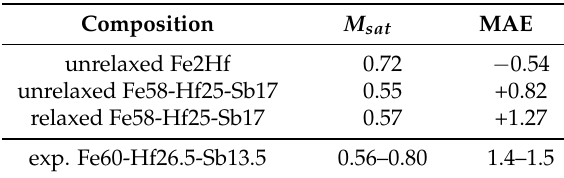
Table 2. Magnetic moment ( M sat , MA/m), and the uniaxial magnetocrystalline anisotropy (MAE ( K 1 ) , MJ/m 3 ). Composition M sat MAE unrelaxed Fe2Hf 0.72 − 0.54 unrelaxed Fe58-Hf25-Sb17 0.55 +0.82 relaxed Fe58-Hf25-Sb17 0.57